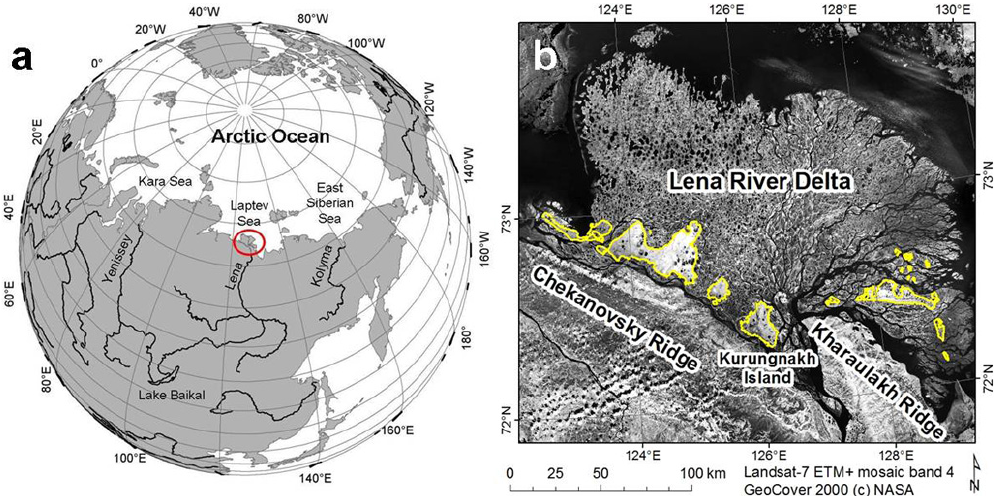
Fig. 1. Location of the study area in the Lena River Delta, North